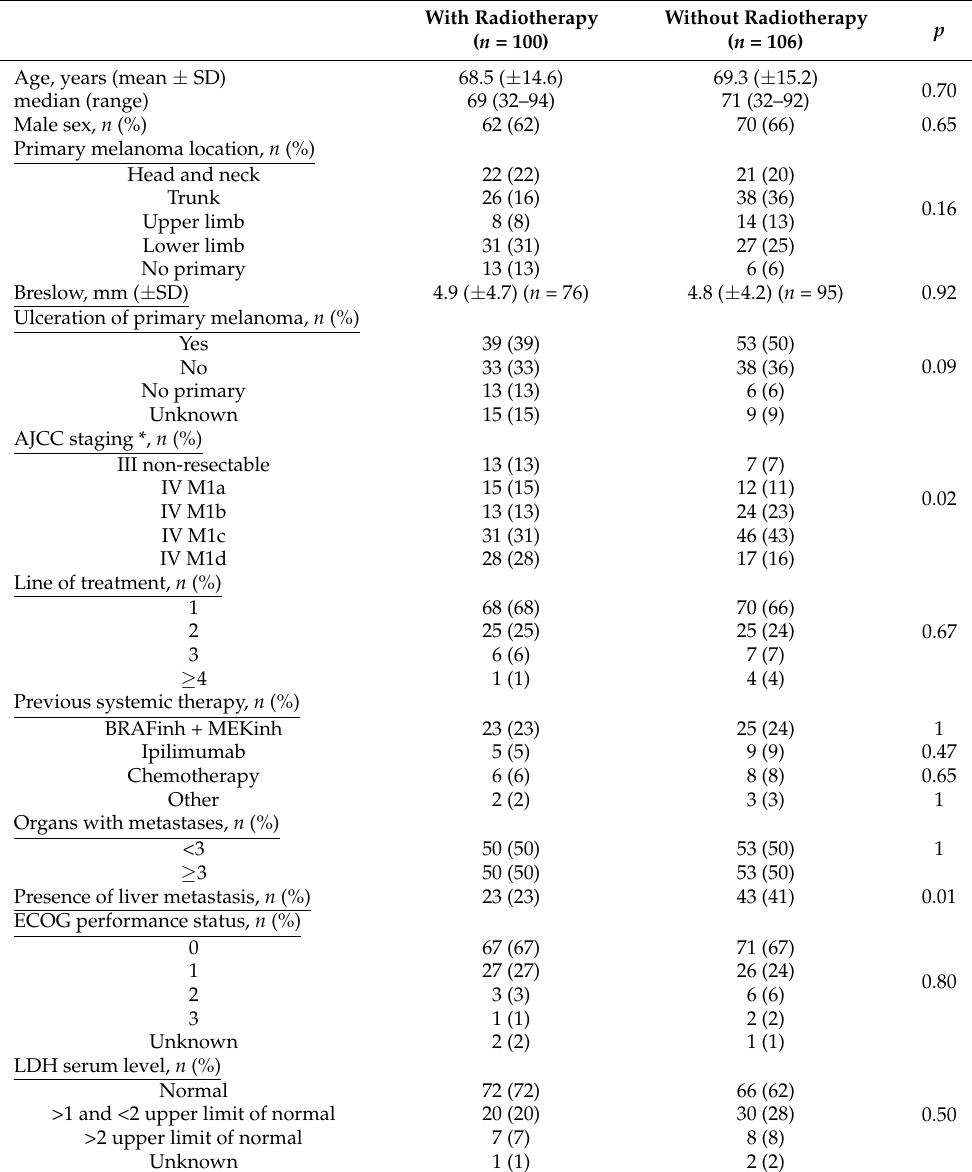
Table 1. Characteristics at anti-PD-1 initiation for radiated and non-radiated patients.